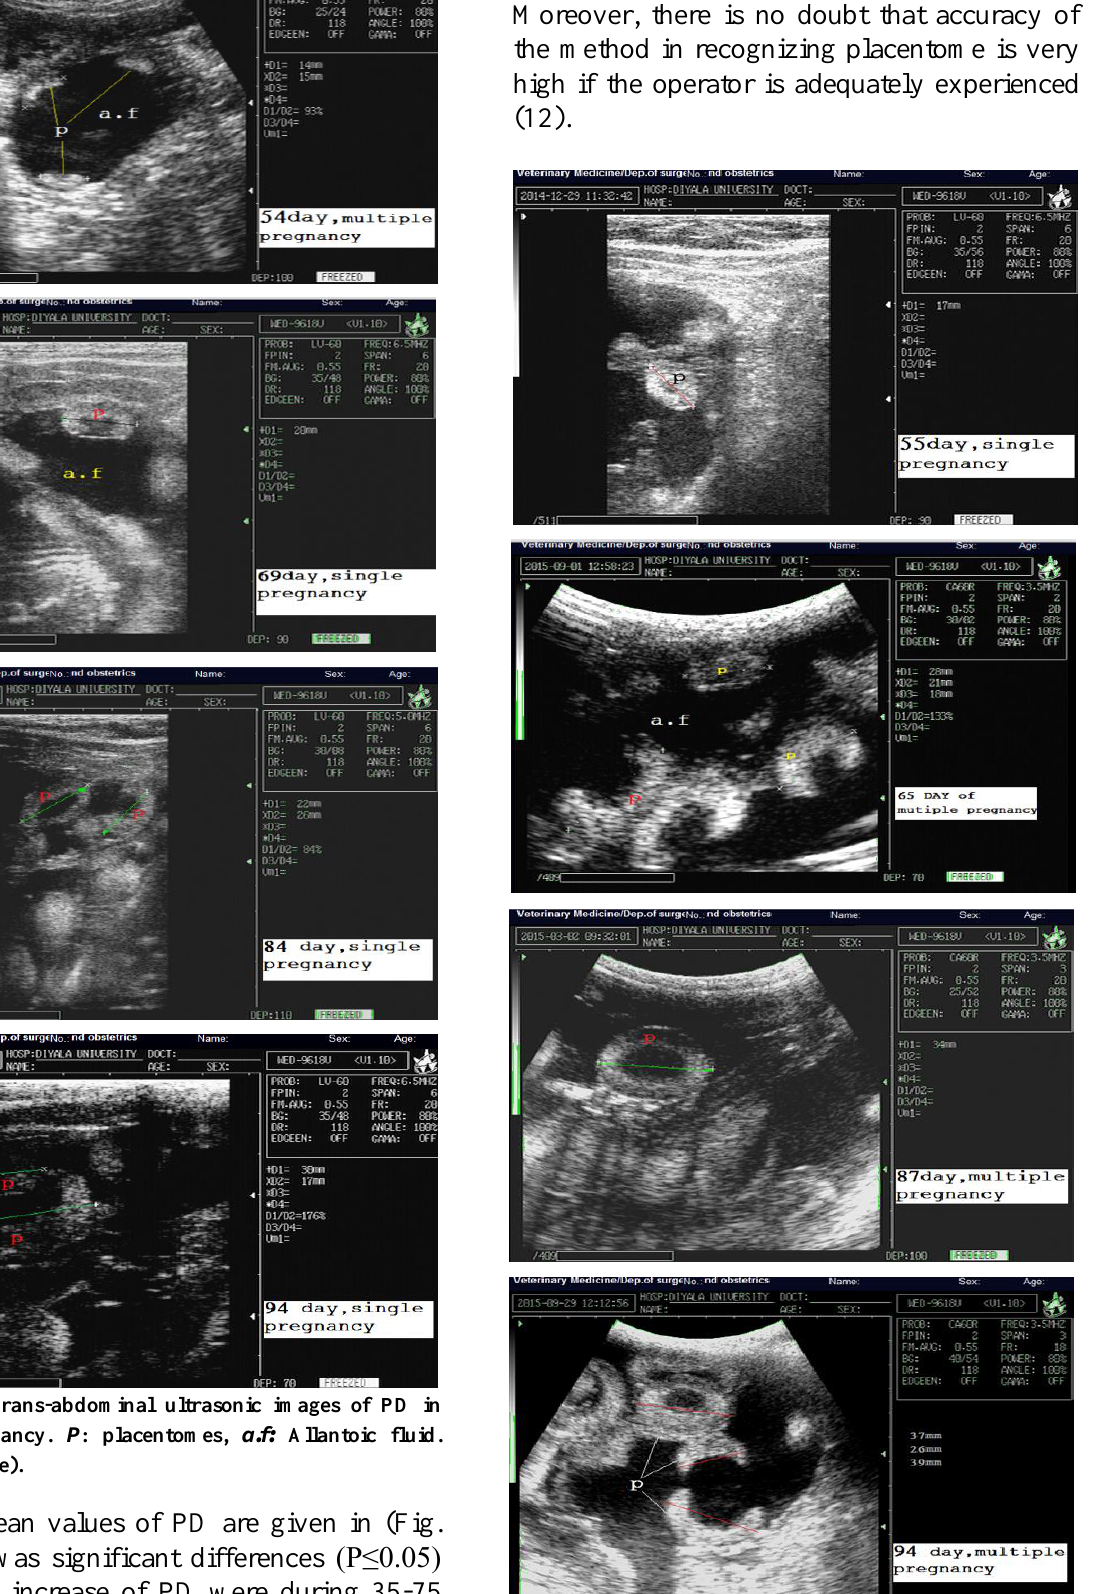
Figure, 5: Trans-abdominal ultrasonic images of PD in multiple pregnancy. P : placentomes, a.f: Allantoic fluid. (Sector